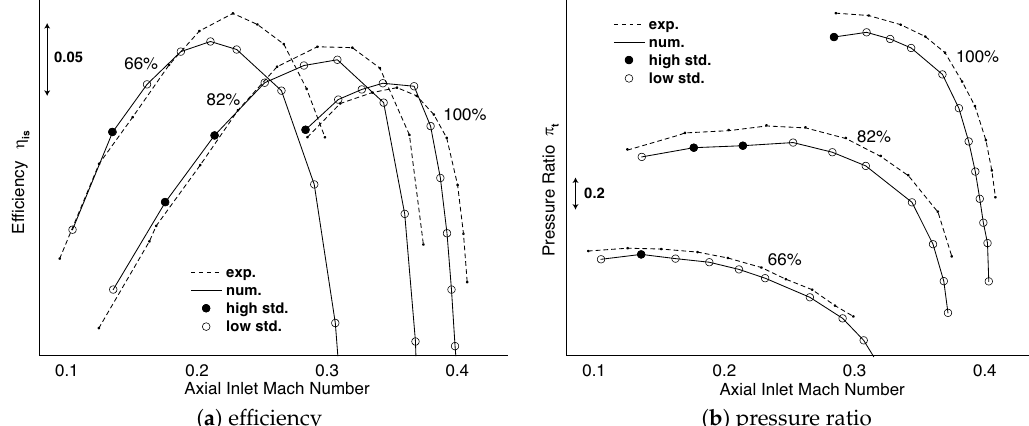
Figure 5. Comparison of measurements and numerical results for compressor configuration